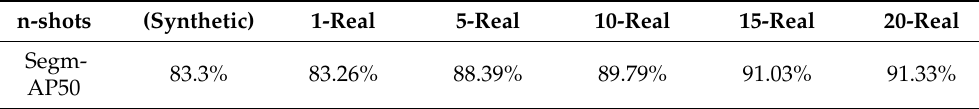
Table 5. Segm-AP50 results comparing {3} with few-shot fine-tuning against the uncontrolled dataset {4} .